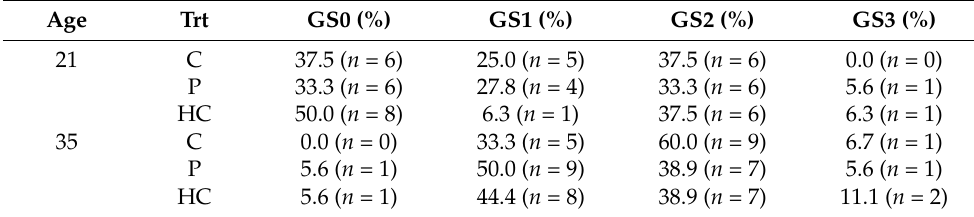
Table 6. Gait scores of chickens at 21 and 35 days of age. Chickens were raised under standard conditions (Control; C), with physical items (P) or with additional human contact